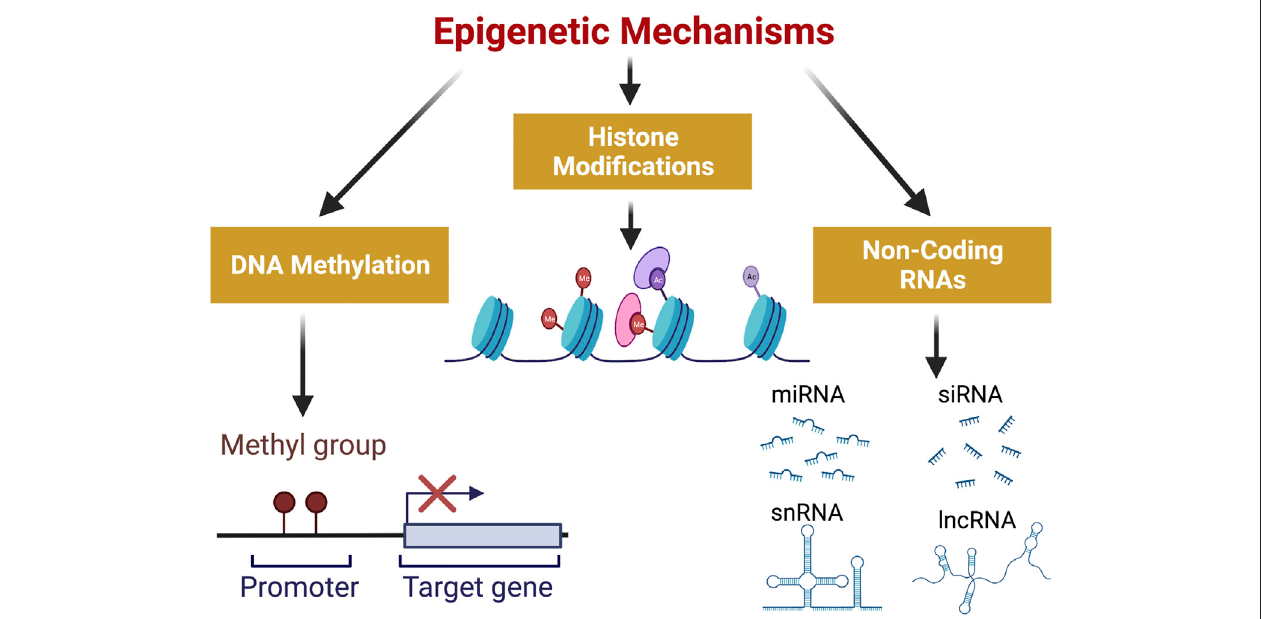
FIGURE1| EpigeneticMechanismsinvolvedingeneexpression:DNAmethylation,HistoneModi fi cationsandNon-CodingRNAsconstitutethethreemechanisms involved in epigenetic regulation of gene expression. Methylation of DNA occurs at gene promoters and hypermethylation represses gene expression. Histone modi fi cations include acetylation and methylation of histones which can either activate or repress gene expression. Non-coding RNAs which consist of short chain non- coding RNAs ( < 200 nt) and long non-coding RNAs ( > 200 nt) also play a signi fi cant role in regulation of gene expression. (Created with BioRender.com). Ac, acetylated histone; Me, methylated histone; miRNA, micro RNA; siRNA, small interfering RNA; snRNA, small nuclear RNA; lncRNA, long non-coding RNA.